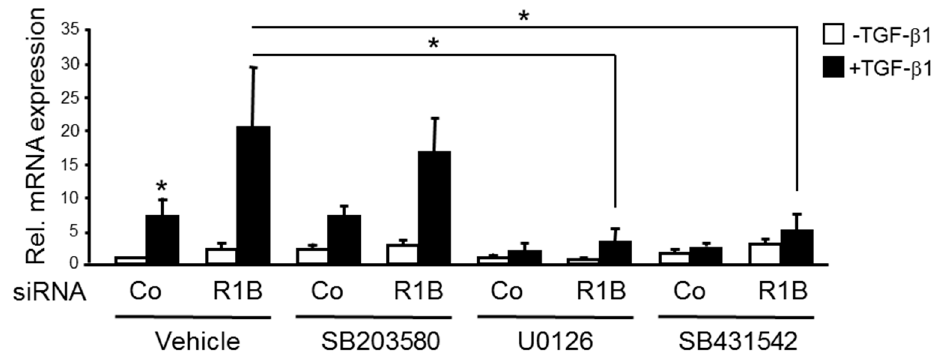
Figure 5. Effect of inhibition of MKK-p38 or MEK-ERK signaling on TGF- β 1-induced regulation of PAR2 mRNA under conditions of a RAC1B knockdown. Panc1 cells were transfected twice with 50 nM each of either control (Co) siRNA or RAC1B (R1B) siRNA. Twenty-four hours after the second transfection, cells were serum-starved overnight and treated with vehicle (dimethylsulfoxide, 0.1%), SB203580 (10 μ M), UO126 (10 μ M), or SB431542 (5 μ M). Thirty minutes after the addition of inhibitors, cells received TGF- β 1 and were incubated for another 48 h in medium with 0.5% fetal bovine serum followed by qPCR analysis of PAR2. Data represent the normalized mean ± SD from three independent experiments and are displayed relative to Co siRNA-transfected, vehicle-treated cells set arbitrarily at 1. The asterisks indicate significant differences.